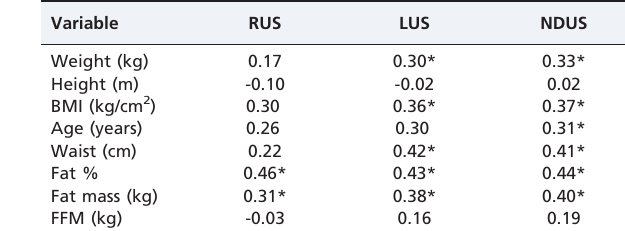
Data are presented as the median (1 st - 3 rd quartile). * p # 0.01 (Mann Whitney Test). SD = Standard Deviation; OBEO = Opened Base, Eyes Open; OBEC = Opened Base, Eyes Closed; CBEO = Closed Base, Eyes Open; CBEC = Closed Base, Eyes Closed.